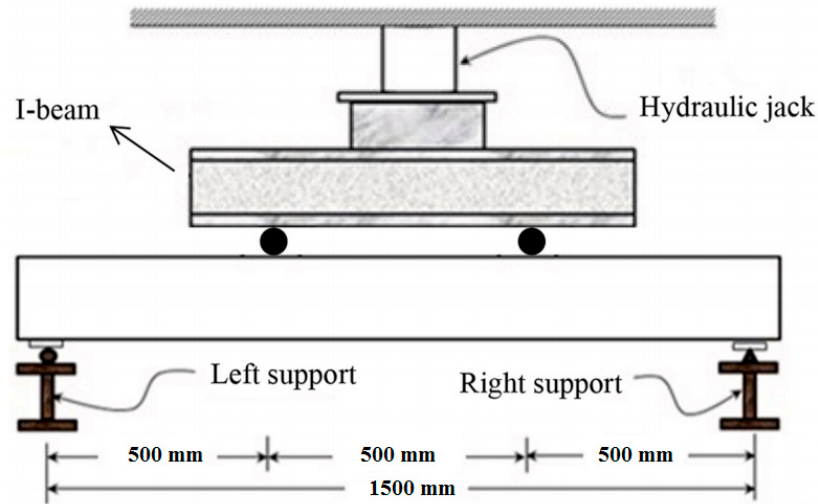
Figure 4. The flexural strength experimental setup.